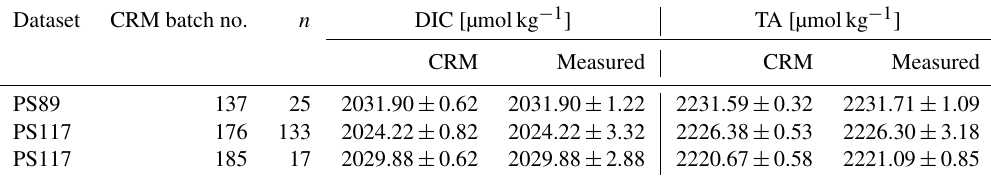
Table C2. Analytical uncertainty of the DIC and TA analyses using the variability of the CRM measurements per CRM batch. The variable n refers to the number of CRMs that were run to obtain the measured values. Values listed for CRMs are certified values by Andrew Dick-